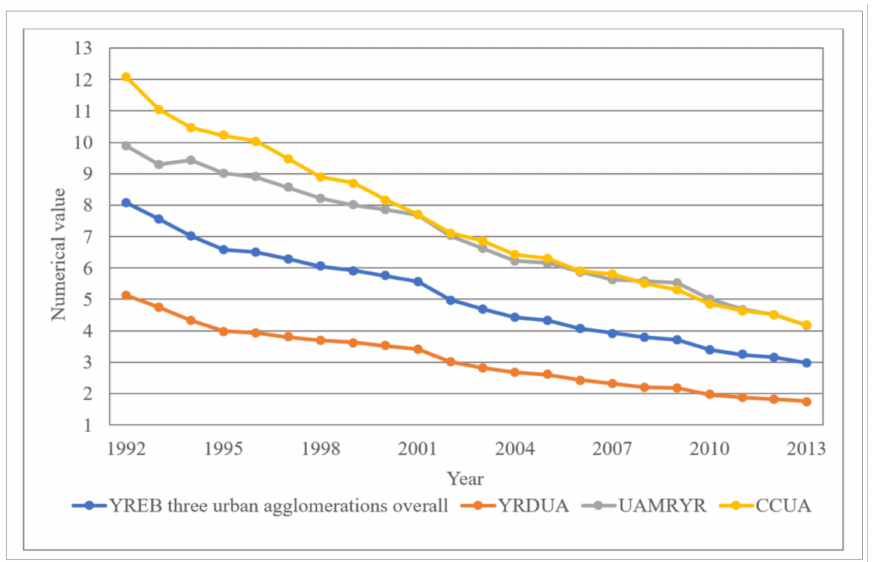
Figure 5. The statistical graph of the CV trend of the EPC of YREB’s three major urban agglomerations from 1992 to